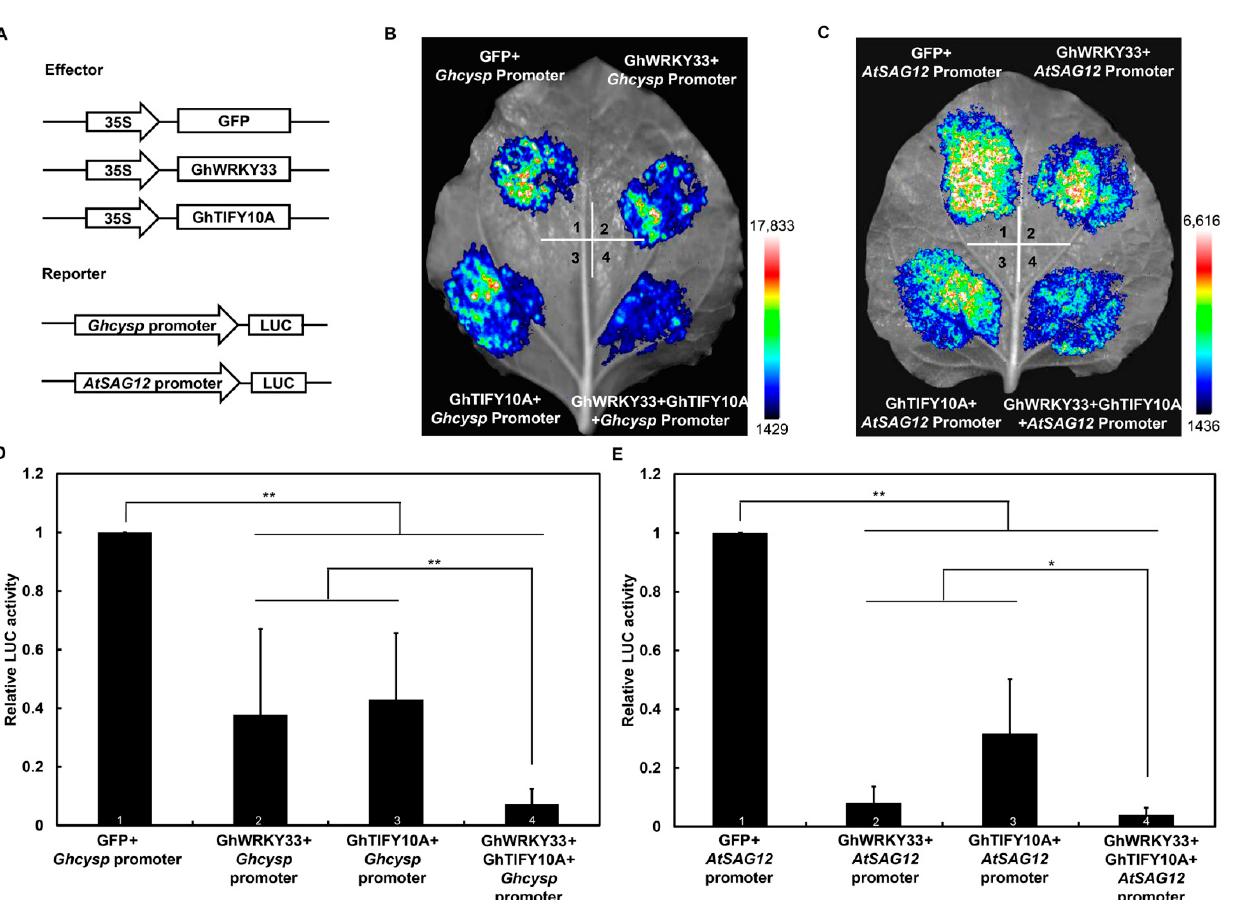
Figure 6. Both GhWRKY33 and GhTIFY10A delayed JA-induced leaf senescence. ( A , J ) Phenotypes of indicated genotypes. The wild-type leaves showed a more severe JA-induced senescence pheno- type than both GhWRKY33 and GhTIFY10A overexpression lines upon 100 μ M MeJA treatment. ( B , K ) Chlorophyll content in detached full-grown rosette leaves of the indicated genotypes. ( C – I , L – R ) Transcript levels of AtSAGs, AtCAB1, and AtRBCS1A in the indicated genotypes. Date from three biological replicates were analyzed by ANOVA, and asterisks indicate significant differences com- pared with WT (** p < 0.01).